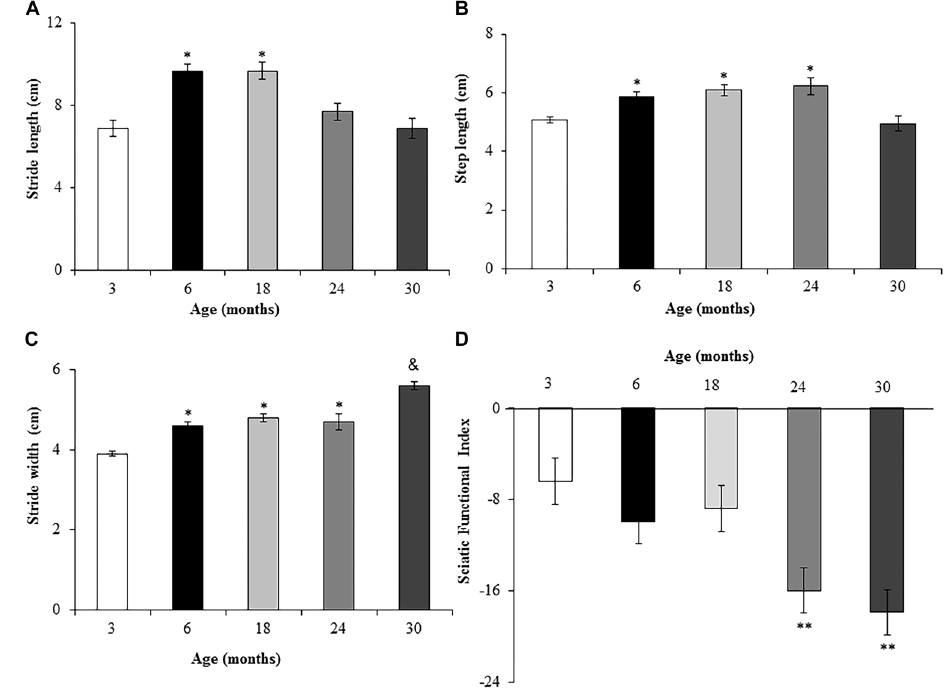
Figure 4. Assessment of stride length ( A ), step length ( B ), stride width ( C ), and sciatic functional index ( D ) of Wistar rats of different ages. Data are reported as means ± SE. *P o 0.05 compared to 3-month-old rats; **P o 0.05 compared to 3-, 6-, and 18-month-old rats; & P o 0.05 compared to all groups (P o 0.05, one-way ANOVA followed by Tukey ’ s post hoc